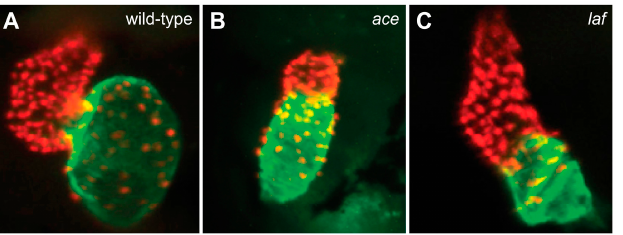
Figure 3. FGF and BMP signaling promote ventricular and atrial cardiomyocyte formation, respec- tively. Compared to the chambers of the wild-type heart at 48 hpf ( A ), the ace ( fgf8a ) mutant heart ( B ) exhibits a substantially reduced ventricle, and the laf ( acvr1l ) mutant heart ( C ) exhibits a substantially reduced atrium. Red fluorescence labels cardiomyocyte nuclei, and green fluorescence indicates localization of Amhc. Images adapted from [54,59].